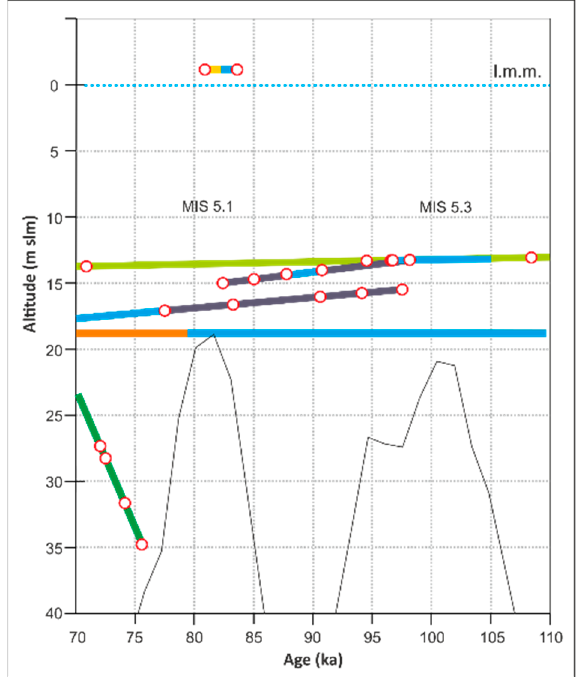
Figure 14. Zoom 1 of Figure 15. Light green line: DWBAH flowstone [11]; orange line: Stalagmite ASI ( − 18.5) from Argentarola cave, − 18.5 m [2]; black line: Speleothems K14 and K18; yellow and blue line: Mallorca POS; green line: Plemmirio [64]; fine black line: global sea level curve reconstructed by [88].